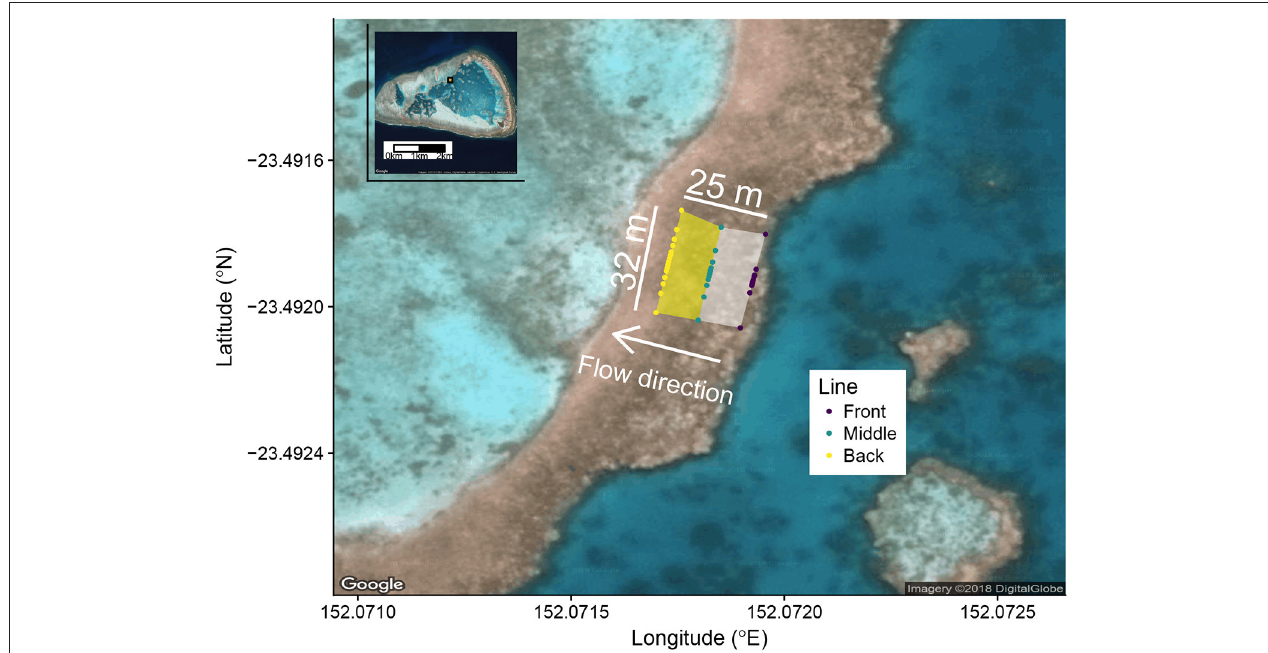
FIGURE 1 | Google Earth image of the study site with One Tree Island as an inset in the upper left corner. The orange rectangle with black border in the inset shows the location of the study site within One Tree Island. Colored dots show the position of all sampling locations. The front zone is defined between the front and middle lines (white shaded area). The back zone is defined between the middle and back lines (yellow shaded area). The white arrow shows the direction of gravitational flow from First Lagoon to Third Lagoon at low tide due to ponding.